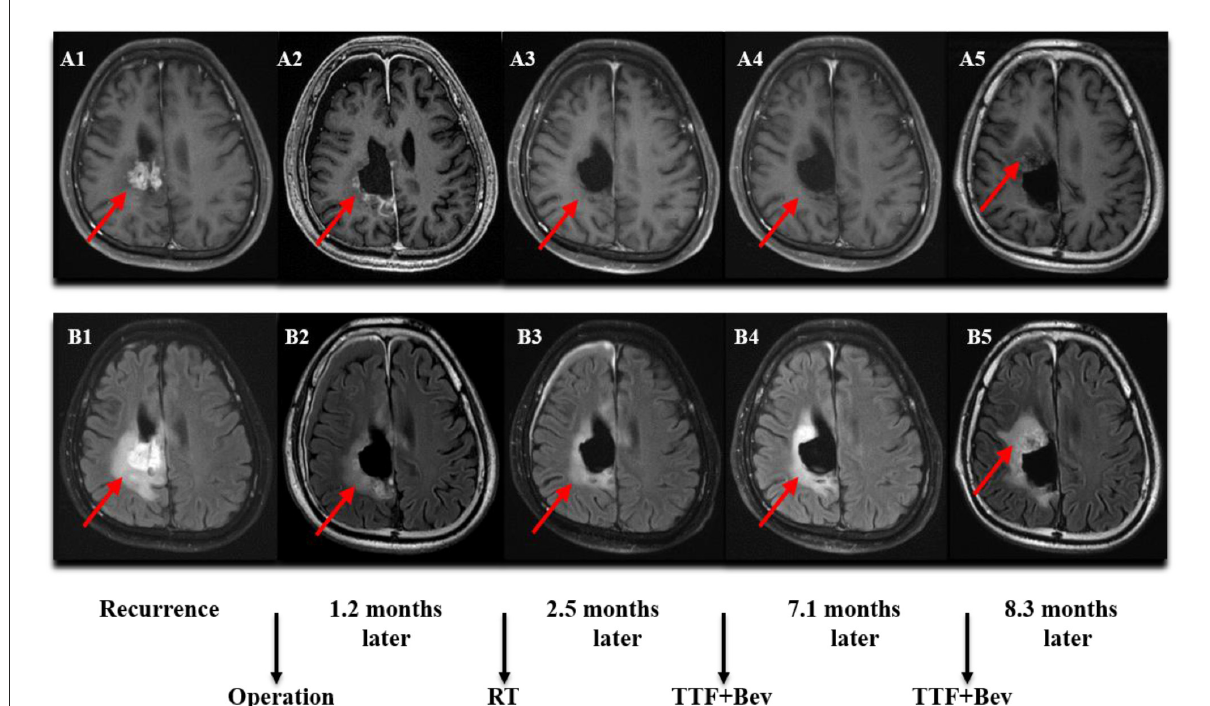
FIGURE3 MRI (Magnetic Resonance Imaging) changes of recurrent GBM (rGBM). (A1–A5) Contrast-enhanced MRI; (B1–B5) MRI-Flair. MRI images followed-up every 2 months before and after treatment. Only some of the images were exhibited. The arrow indicates the tumor and tumor bed. This patient was followed-up for 8.3 months and he developed a disease progression.